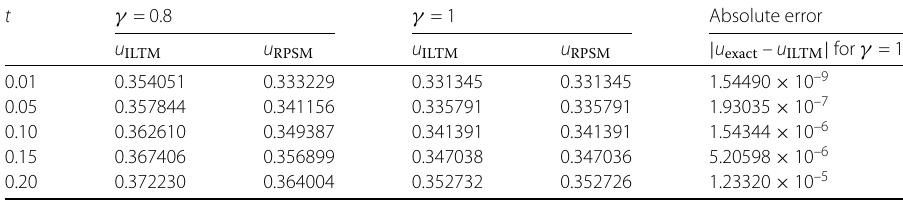
Table 2 Numerical comparison between approximate solutions u ILTM , u RPSM and exact solution of (26) for y = x =